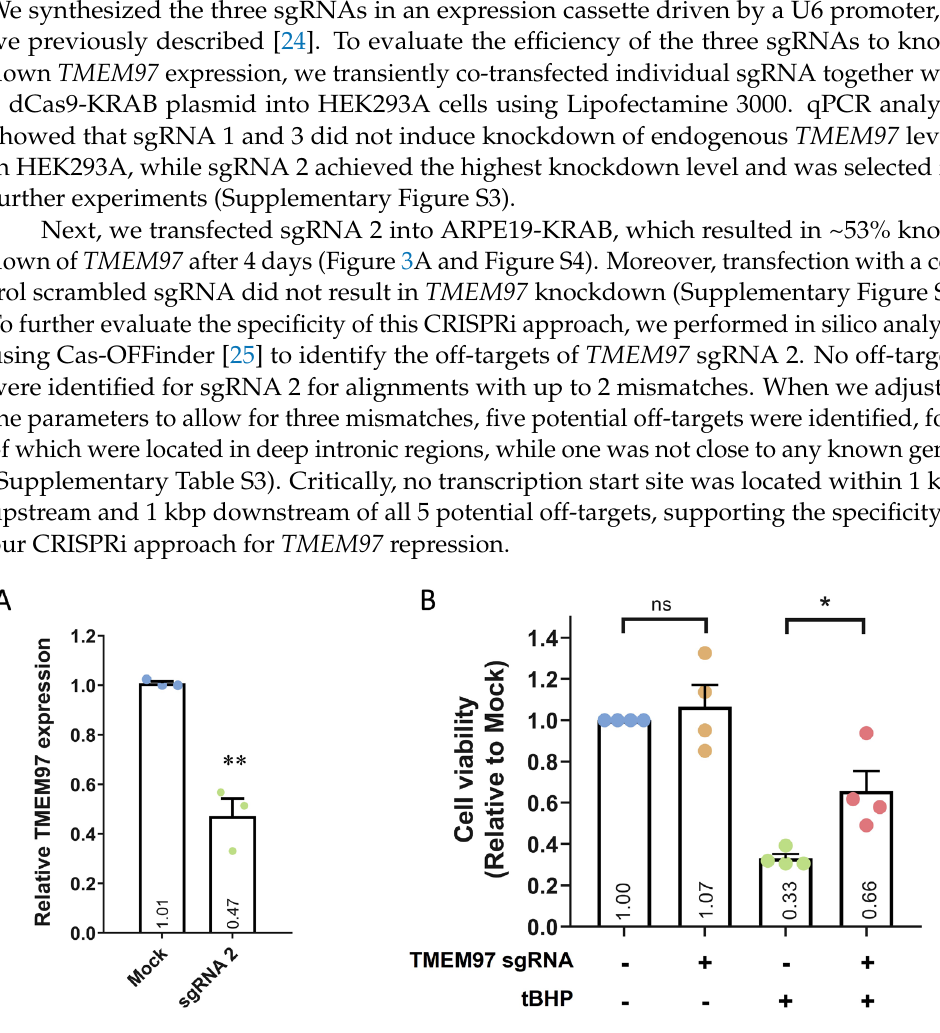
Figure 3. CRISPRi-mediated TMEM97 knockdown and its effect on cell viability. ( A ) qPCR analysis of TMEM97 knockdown using CRISPRi in ARPE19-KRAB. Results are presented as the mean ± SEM of three biological repeats, each with three technical repeats. ** indicates p < 0.01. ( B ) Cell viability analysis of ARPE19-KRAB following TMEM97 knockdown in the presence or absence of tBHP. Results are presented as the mean ± SEM of four biological repeats, each with four to six technical repeats. ns indicates not significant; * indicates p < 0.05.